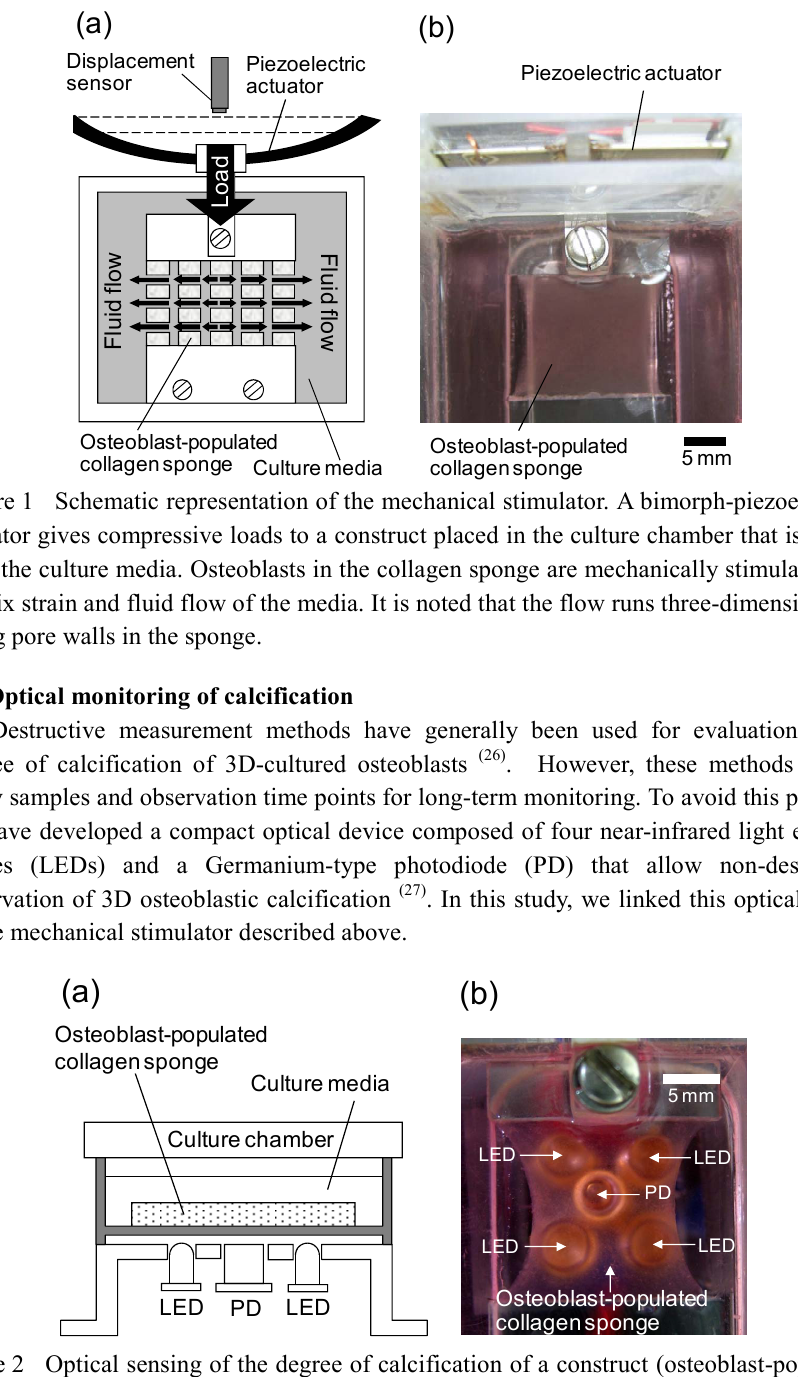
Figure 2 Optical sensing of the degree of calcification of a construct (osteoblast-populated collagen sponge). (a) Light emitting diodes (LEDs) irradiate a construct in the culture chamber with near-infrared light at 850 nm. Light reflected from the construct is detected by a Germanium-type photodiode (PD). (b) Top view of the optical sensing unit installed underneath a culture